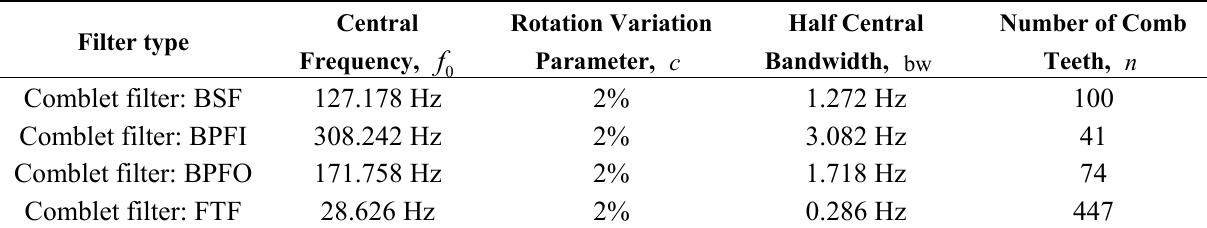
Table 3. The parameters of each comblet filter with =25.6